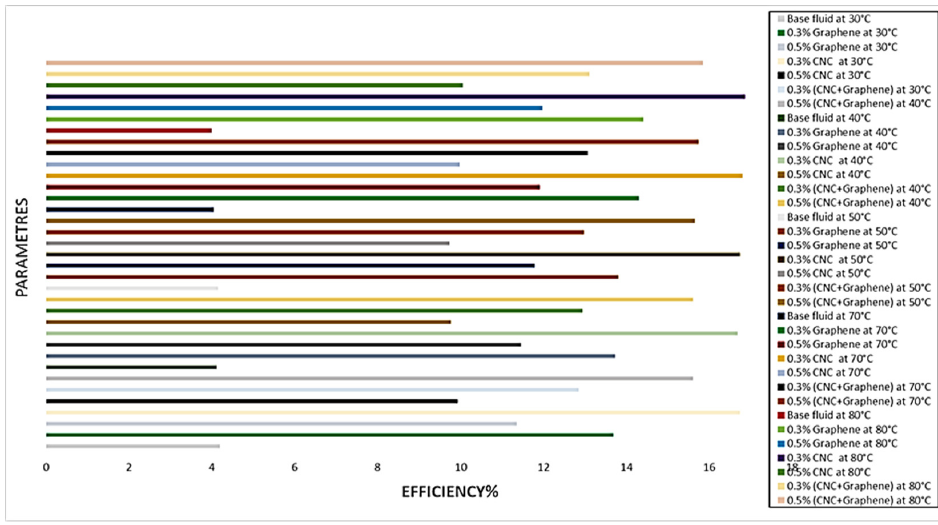
Figure 19. Improvement in the efficiency of flat plate solar